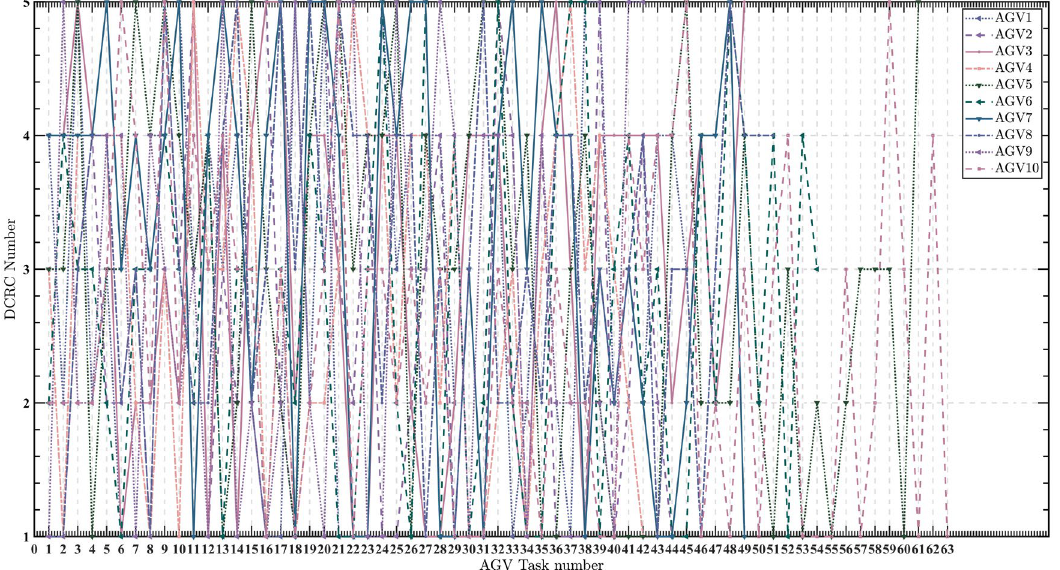
Figure 17. AGV job sequence for 500 container tasks.